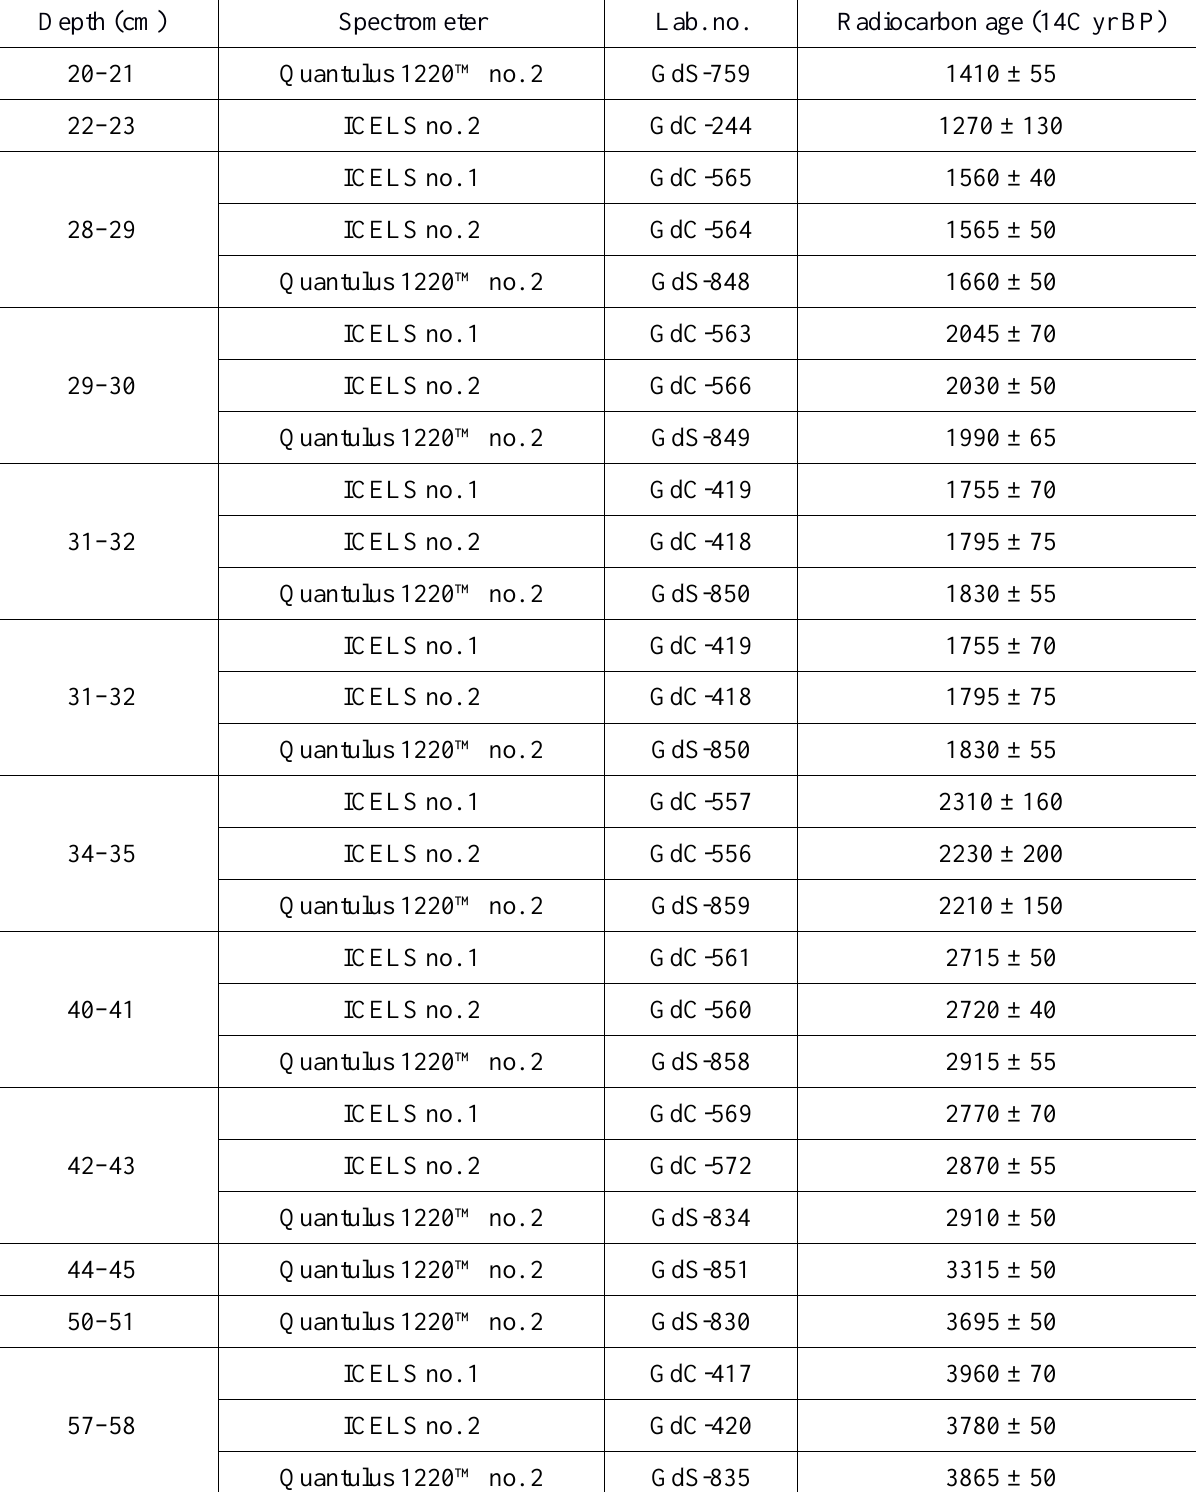
Table A1. 14 C dates by layer of a peat profile from Żyglin site obtained on three different spectrometers, after Tudyka & Pazdur (2010, 2012). For the deepest layer (125–127.5 cm), sample age (*) is 1160 14 C yr younger than the erroneous result published by Tudyka & Pazdur (2010), which was revised after we noticed a systematic decrease of standard count rate caused by a sample elevator breakdown in the Quantulus